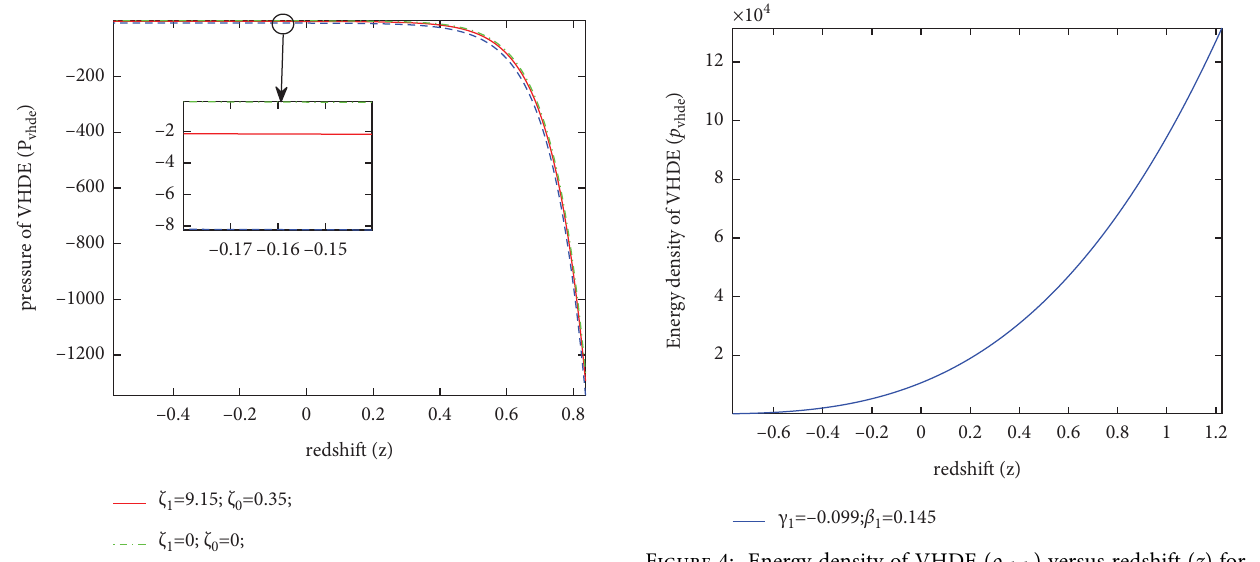
vhde ) versus redshift ( z ) for